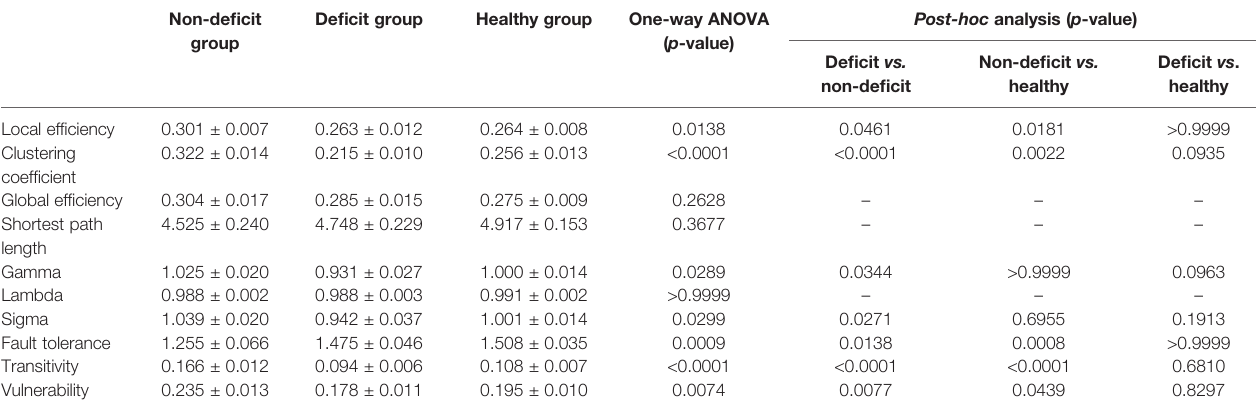
TABLE 2 | Global properties compared between the patient and healthy groups for tumors located on the left